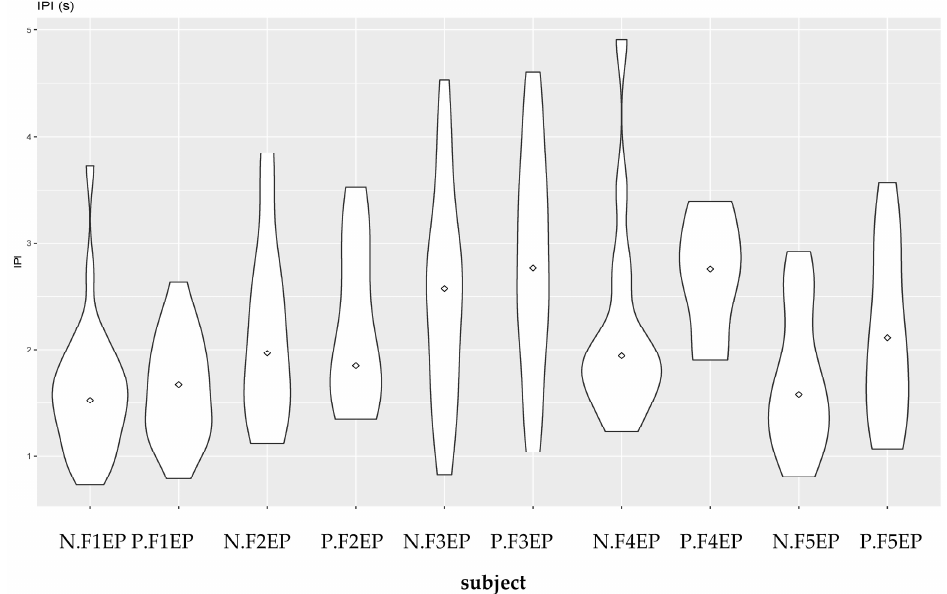
Figure 2. IPI (s) violin plots for the five Portuguese female participants of the Current Set. Valence is referred to as N(egative) or P(ositive) in the x-axis, with the speaker ID.